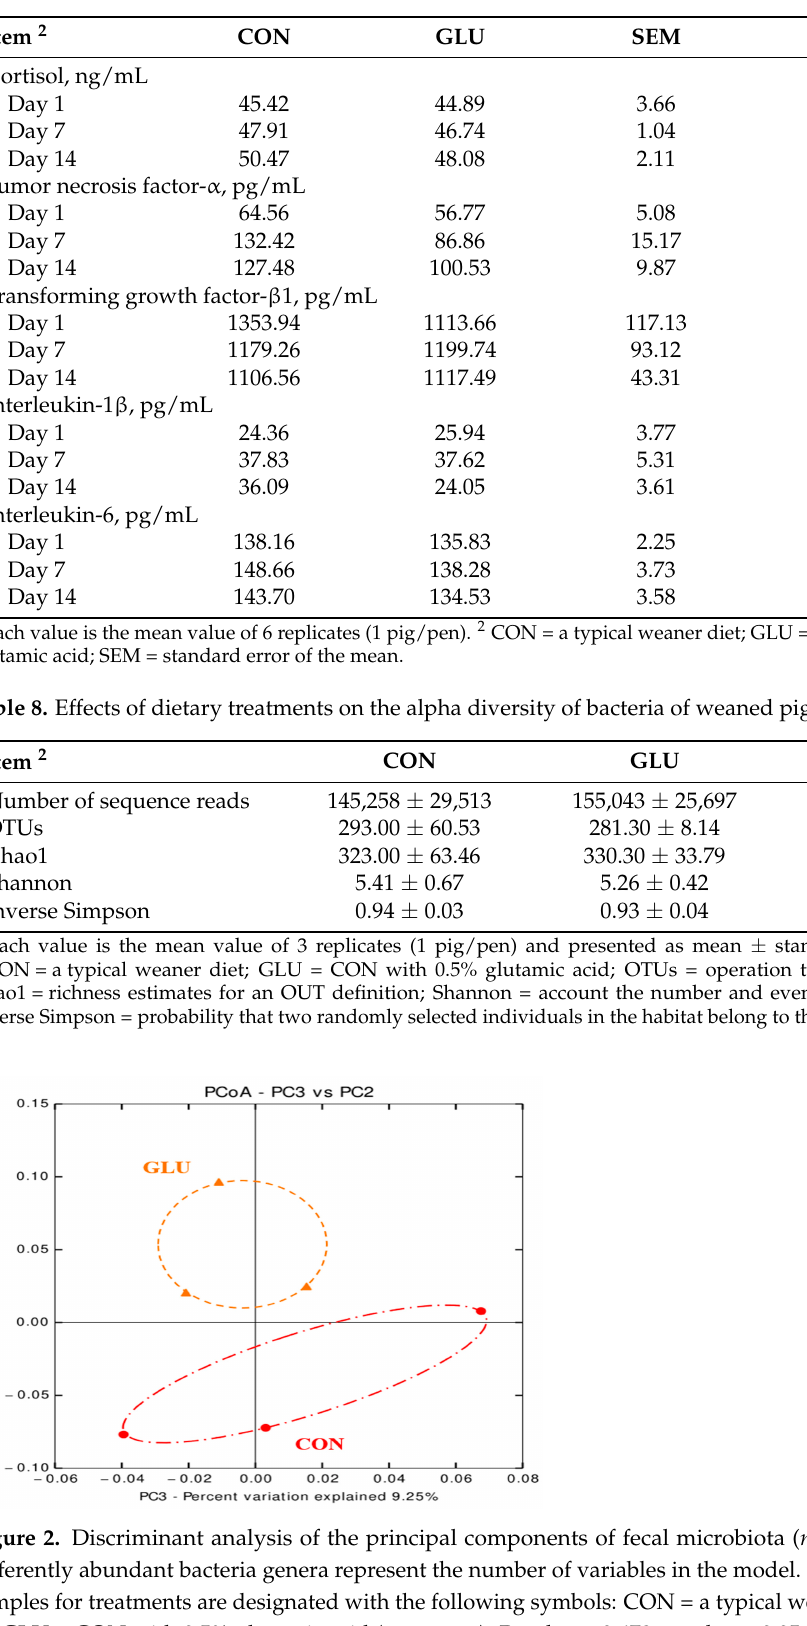
Table 7. Effects of dietary treatments on immune responses of weaned pigs 1 .